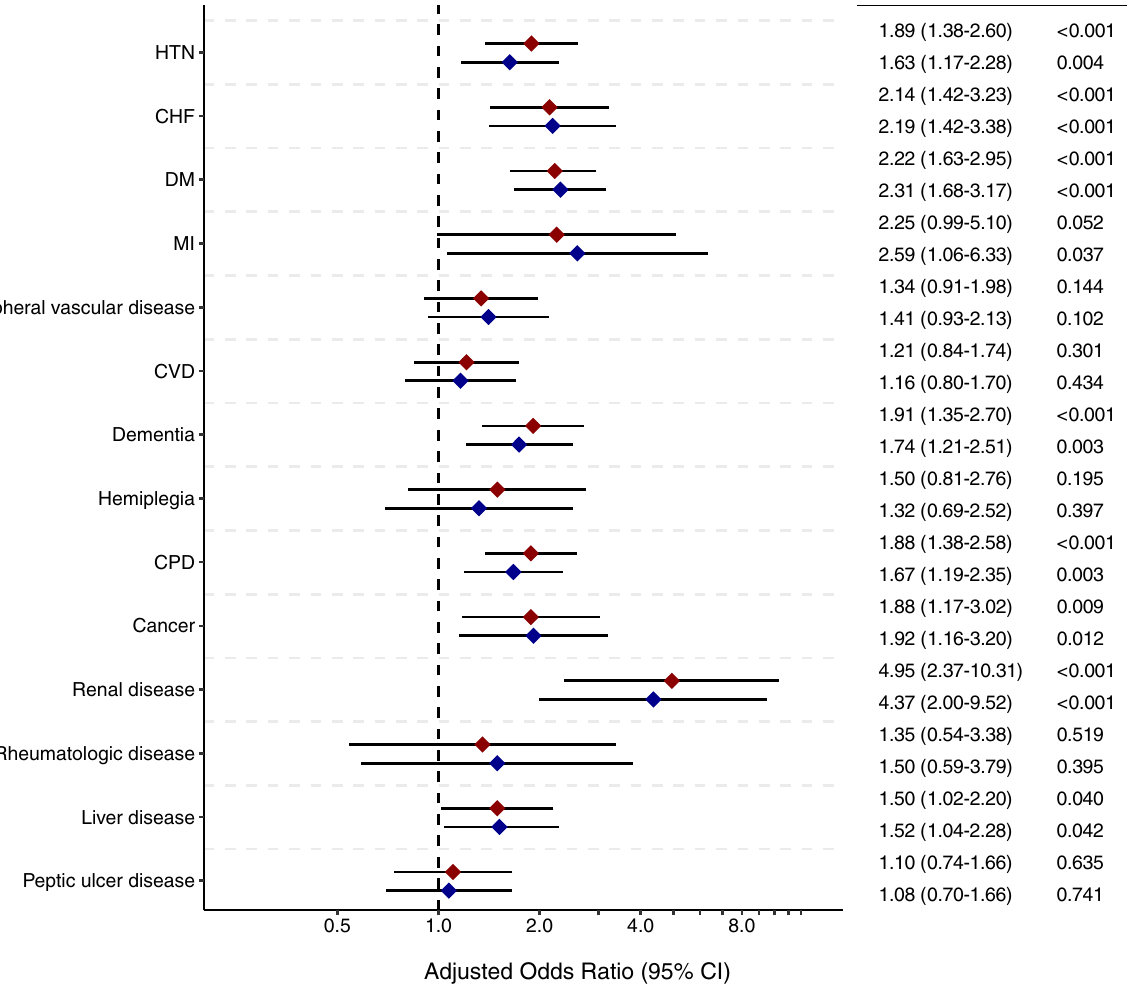
Figure 2. Age- and sex-adjusted odds ratios (95% confidence interval [CI]) of mortality according to the comorbidity of the all-patient (red) and Daegu–Gyeongbuk cohorts (blue) with coronavirus disease (COVID- 19). CHF chronic heart failure, CPD chronic pulmonary disease, CVD cerebrovascular disease, DM diabetes mellitus, HTN hypertension, MI myocardial infarction. R: A language and environment for